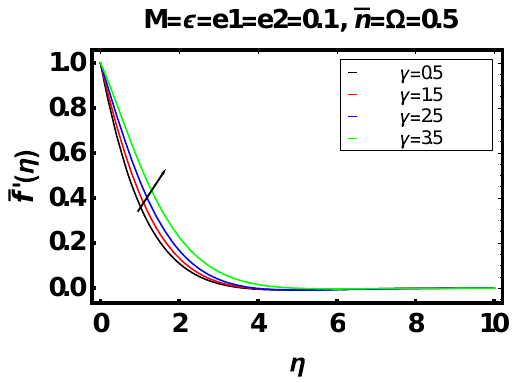
Figure 6. Velocity along 𝑥̅ -direction for variant 𝛾.